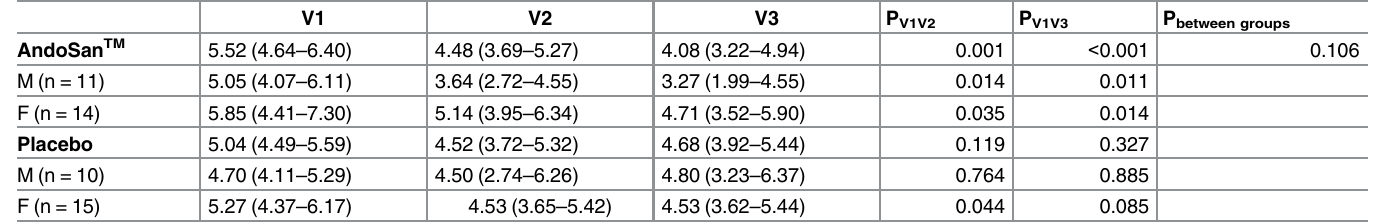
Table 2. Symptom score (SCDAI) for the CD